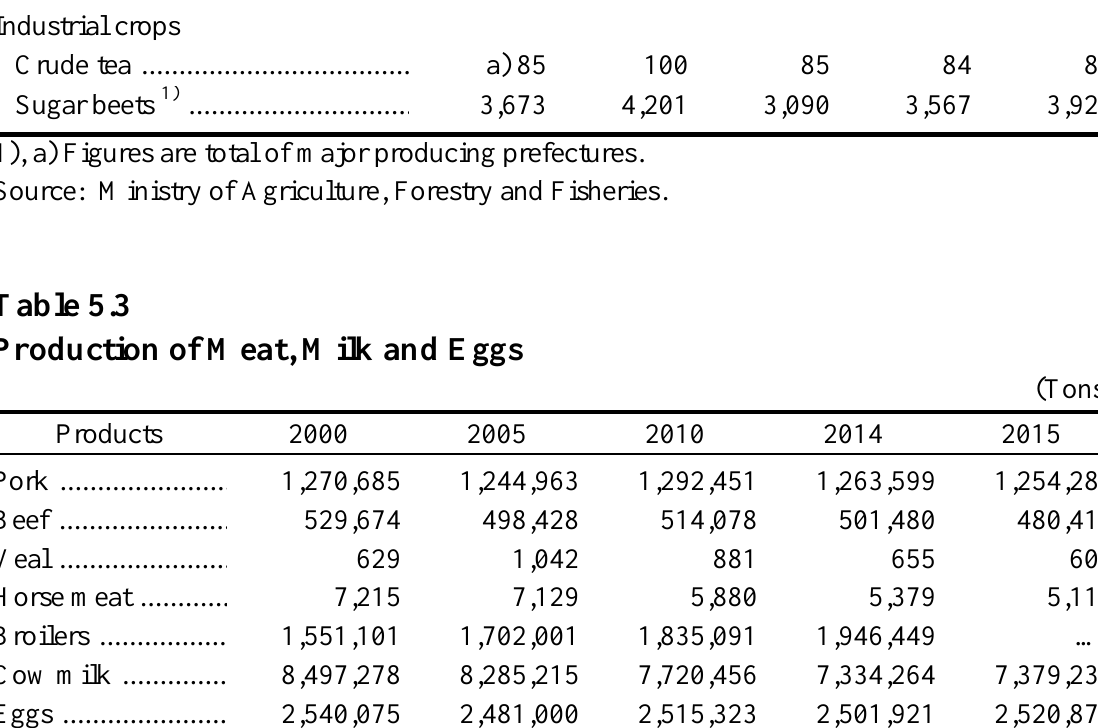
Source: Ministry of Agriculture, Forestry and